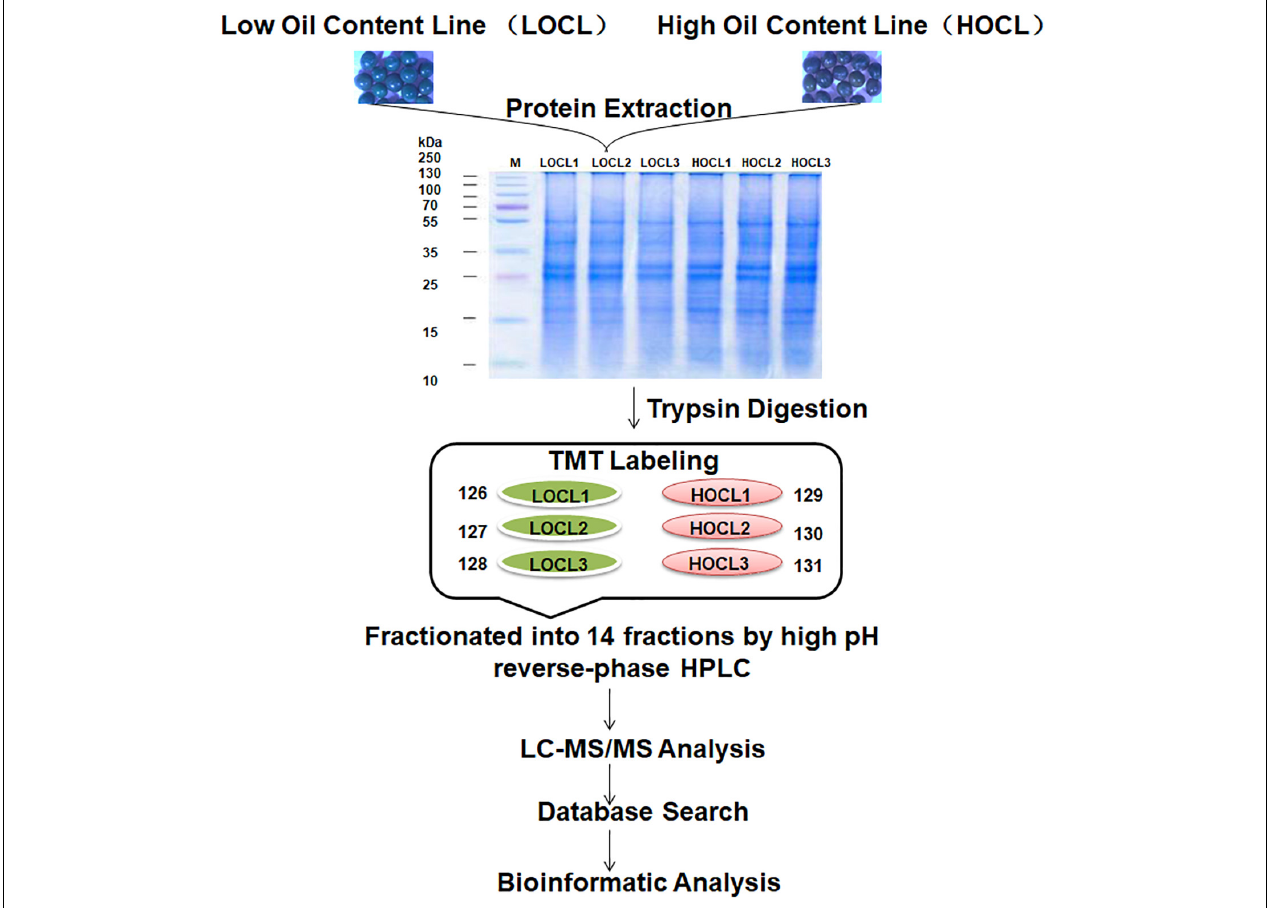
FIGURE 1 | Workflow of TMT labeling-based proteome profiling in B. napus seeds. Total proteins were extracted from 35-DAA seeds of two recombinant inbred lines of the B. napus with high oil content (HOCL) and low oil content (LOCL) (each line with three biological repeats), digested with trypsin after protein quality was checked on SDS-PAGE. The peptides were individually labeled with 6-plex TMT reagent (LOCL: 126, 127, and 128 labels; HOCL: 129, 130, and 131 labels) before combined, fractionated, and analyzed by